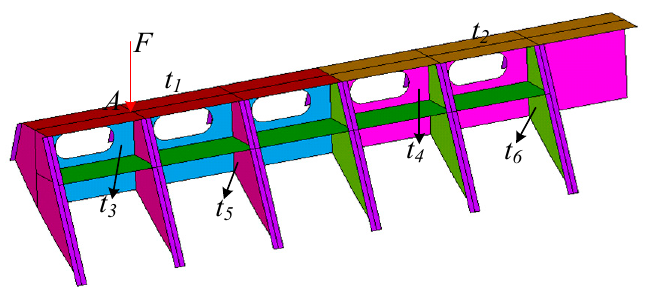
Figure 7. The design variables and loads of the underwater vehicle base. Table 8. The meaning and ranges of the design variables.